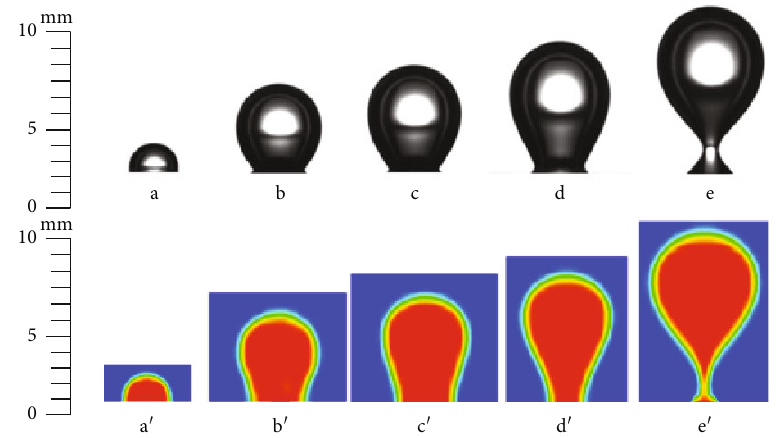
Figure 3: Comparison of experimental and numerically simulated results.